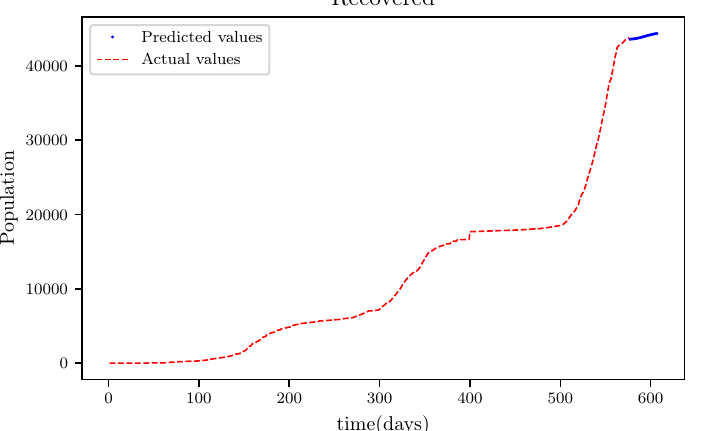
Figure 20. The graph shows a comparison of the predicted infected population values and the actual data infected population for a SIRD model with future predictions.